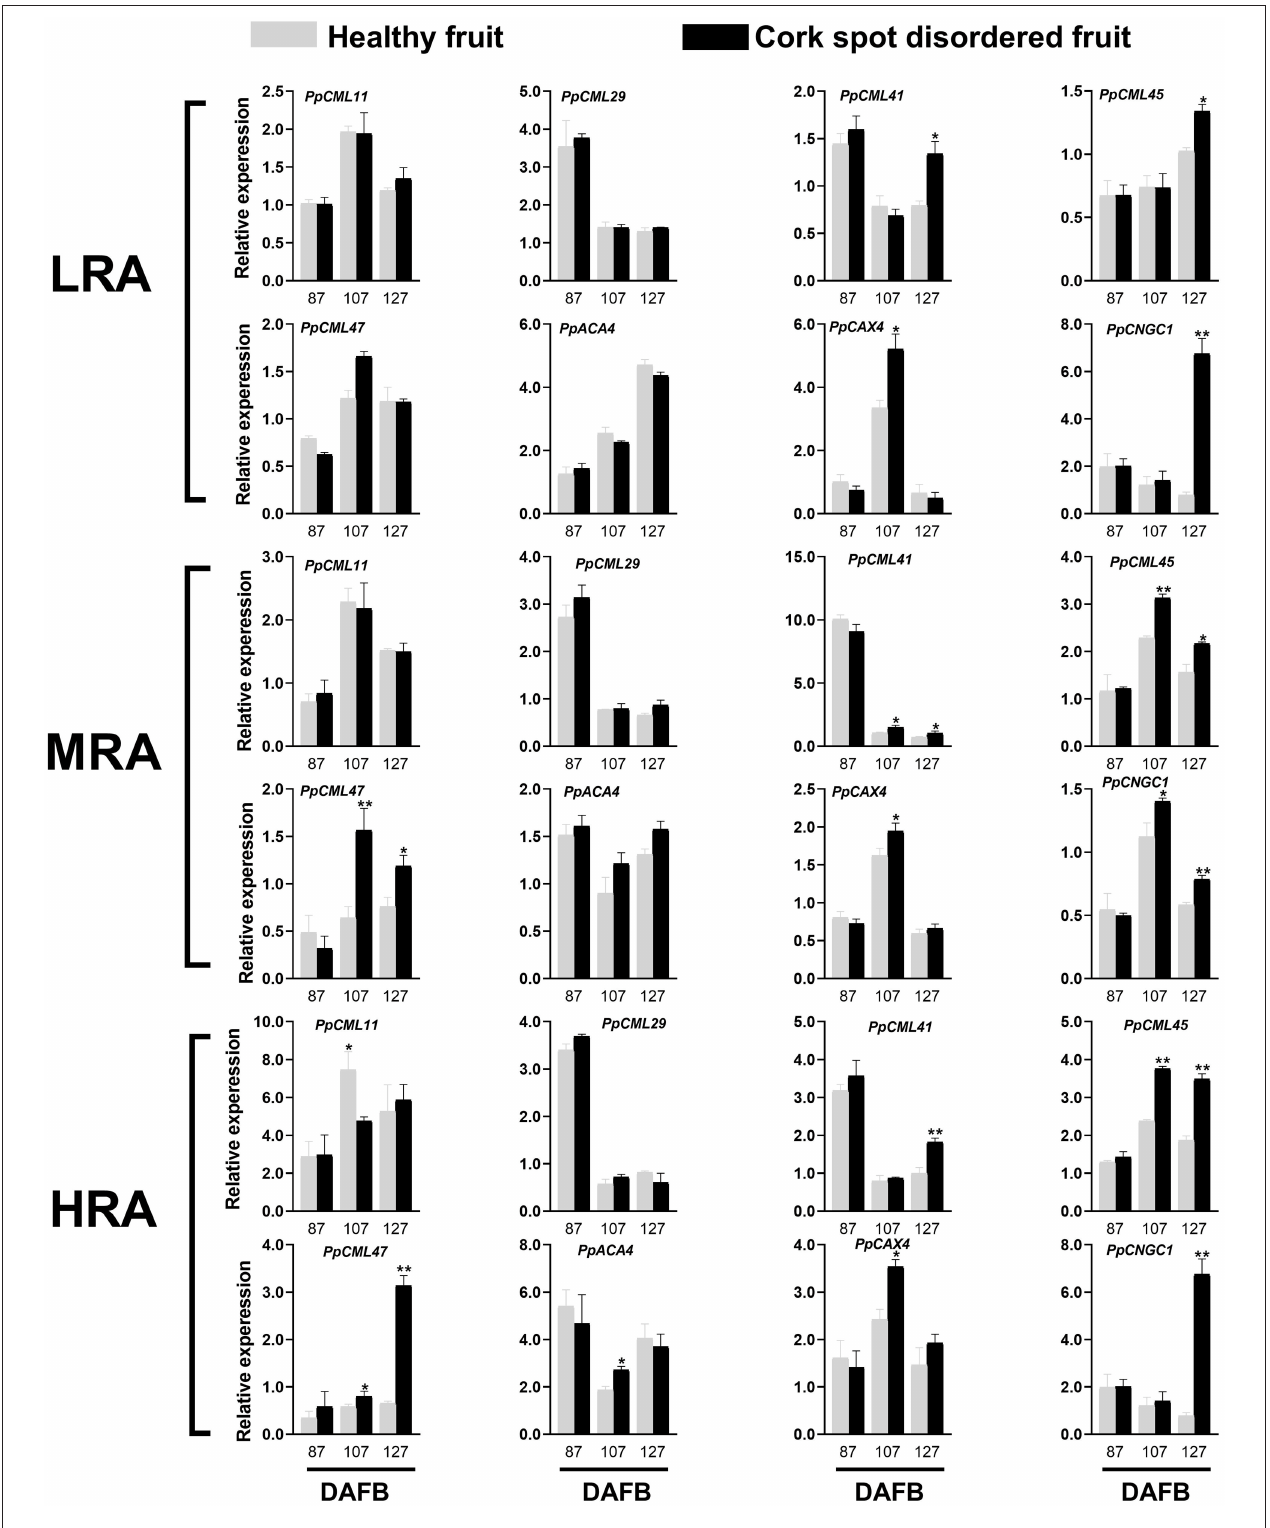
FIGURE 8 | Expression analysis of genes involved in Ca 2 + transport during fruit development. * and ** indicate the significant differences in the expression within the group at a level of P < 0.05 and P < 0.01, respectively.